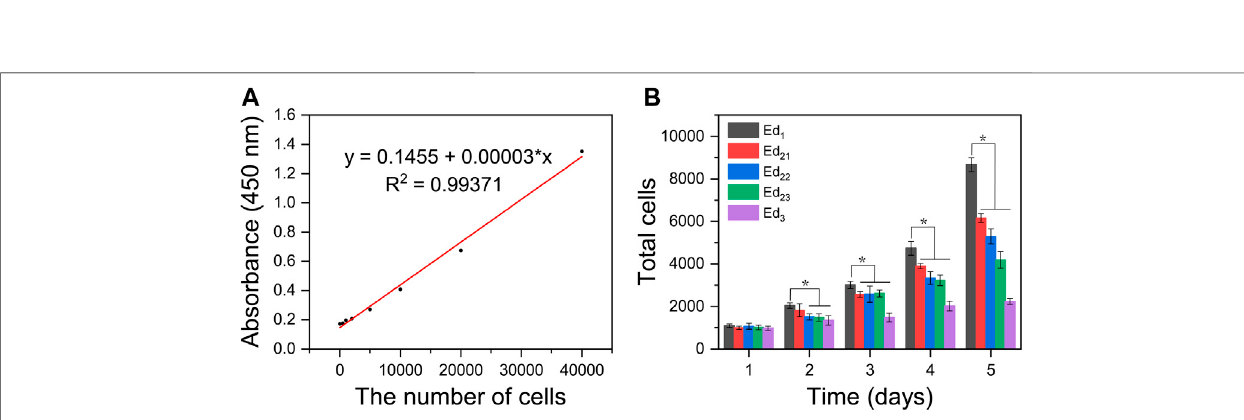
Frontiers in Bioengineering and Biotechnology |